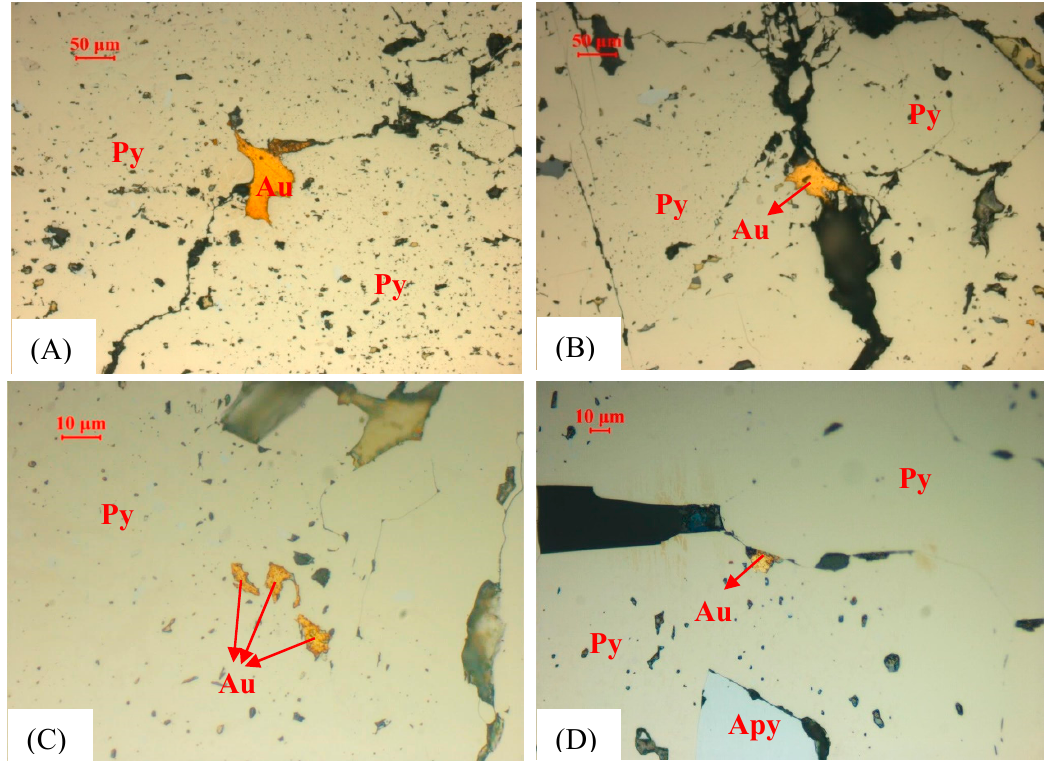
Figure 2. Images of gold in pyrite in reflected light: ( A ) enclosing gold in pyrite; ( B ) intergranular gold in pyrite; ( C ) enclosing gold in pyrite; ( D ) fracture gold in pyrite (Py—pyrite; Apy—arsenopyrite; Au—gold).